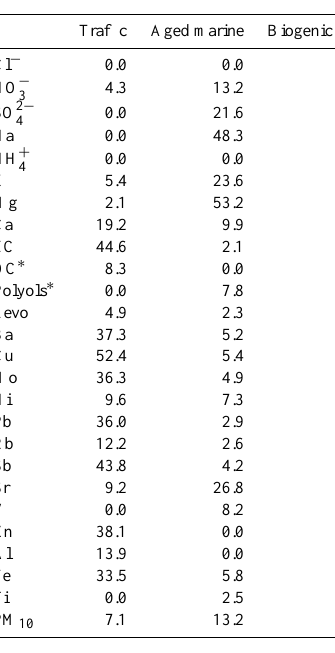
Table 4. Average yearly contributions of the identified sources in % of the measured PM 10